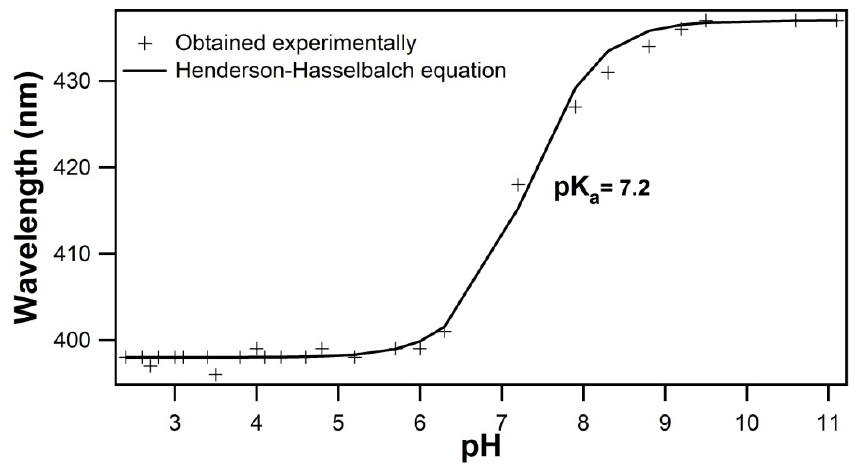
Figure 2. Titration curve of QS-21 in aqueous